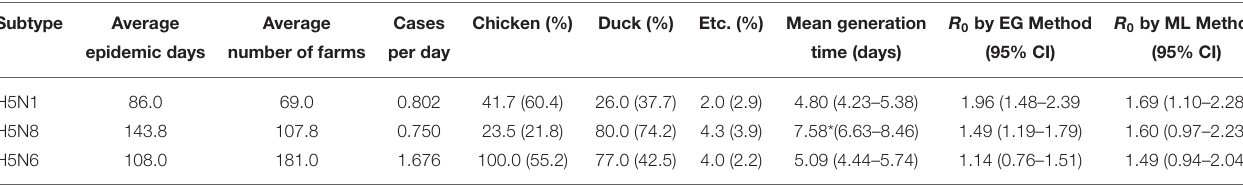
TABLE 3 | Epidemic characteristics, mean generation time, and R 0 in two models by HPAI subtype H5N1, H5N8, and H5N6.